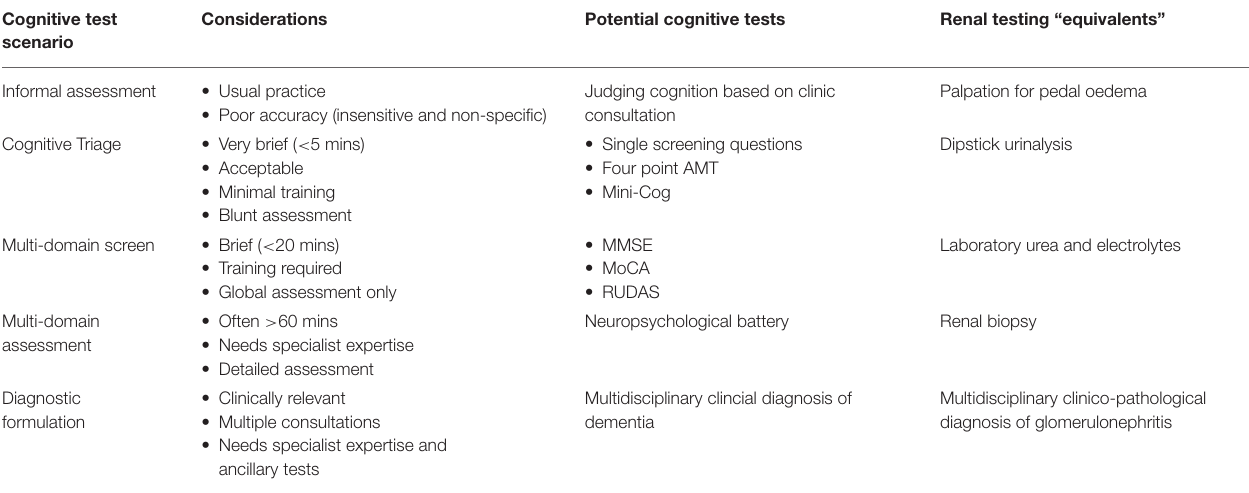
TABLE 1 | Cognitive testing in advanced chronic kidney